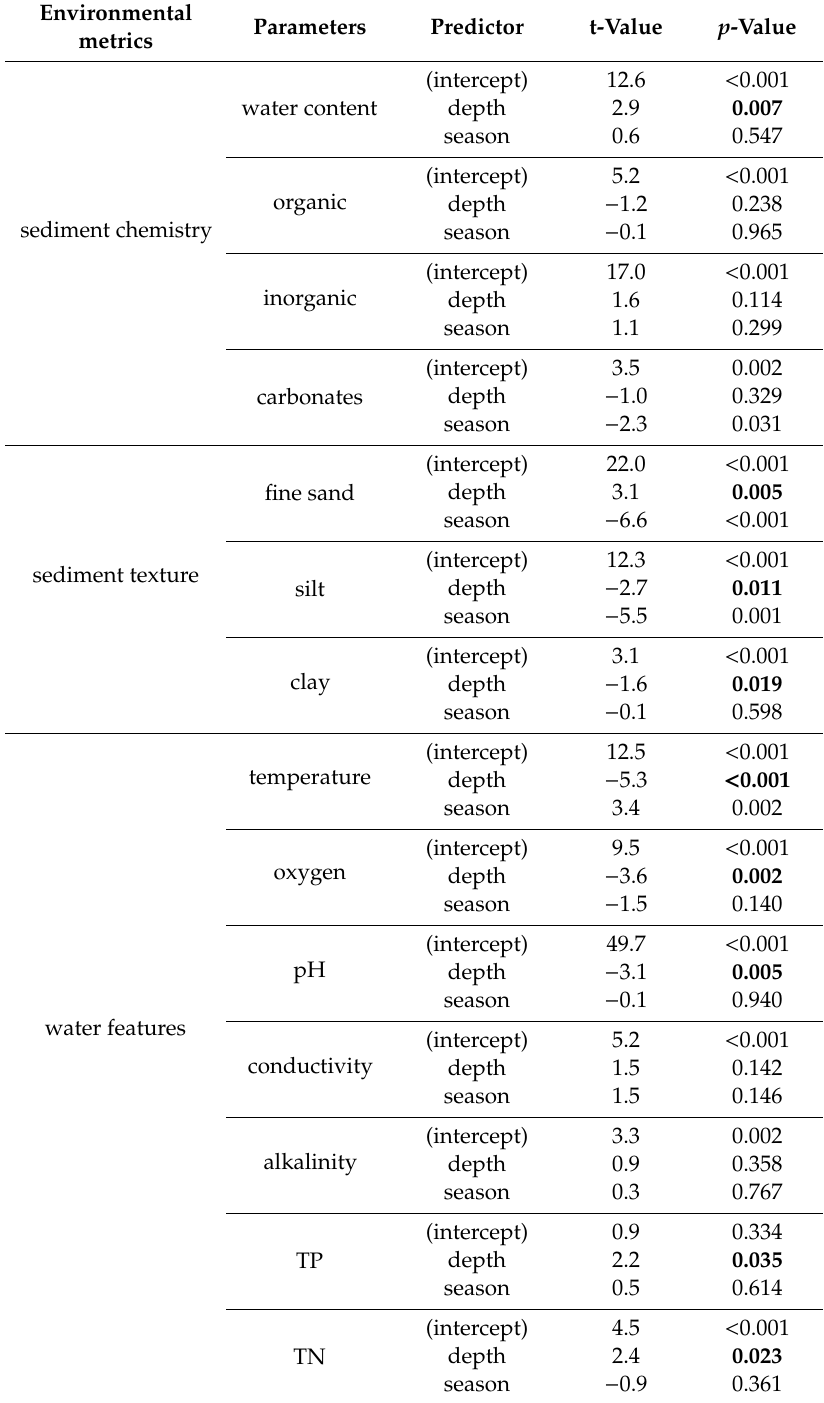
Table 3. Output of the Generalized Linear Mixed E ff ect Models (GLMM) assessing the e ff ect of depth on sediment chemistry, sediment texture and water features, including seasonality as a covariate and sites nested within each lake as random e ff ects. Significant e ff ects of depth are marked in